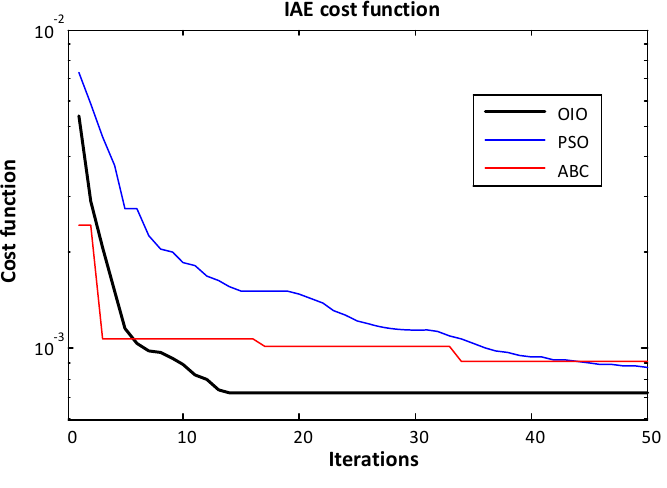
Figure 20. Iteration history for IAE.